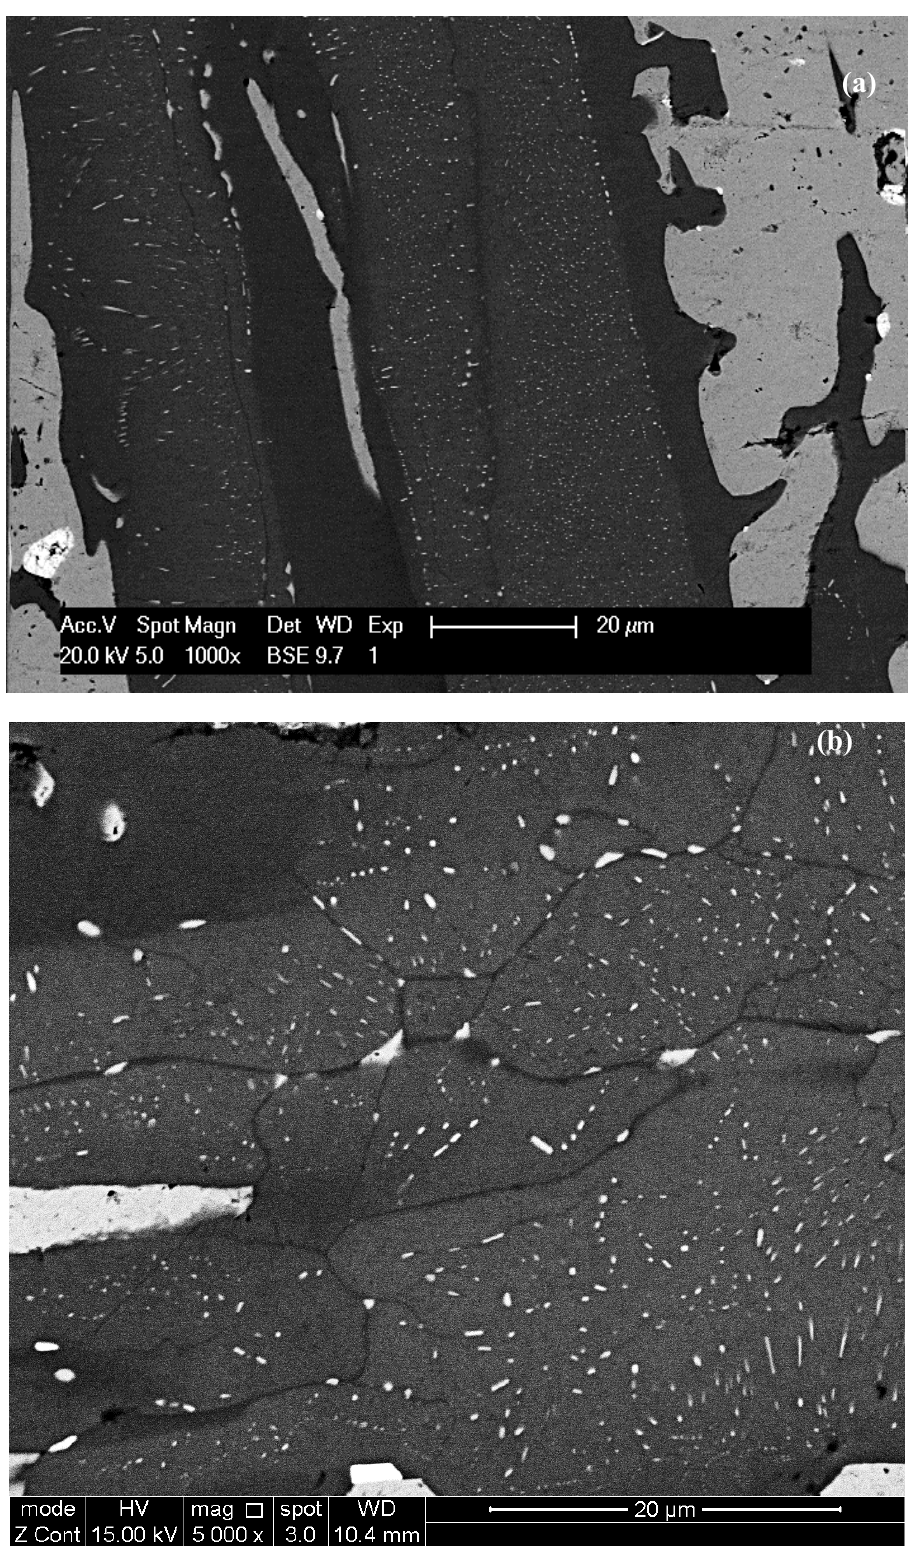
Figure 6. BSE images of heat-treated CM1-OFZ showing precipitation of Nb ss and sub-grains in Nb 5 Si 3 ( a ) 60 mm/h, ( b ) 150 mm/h.